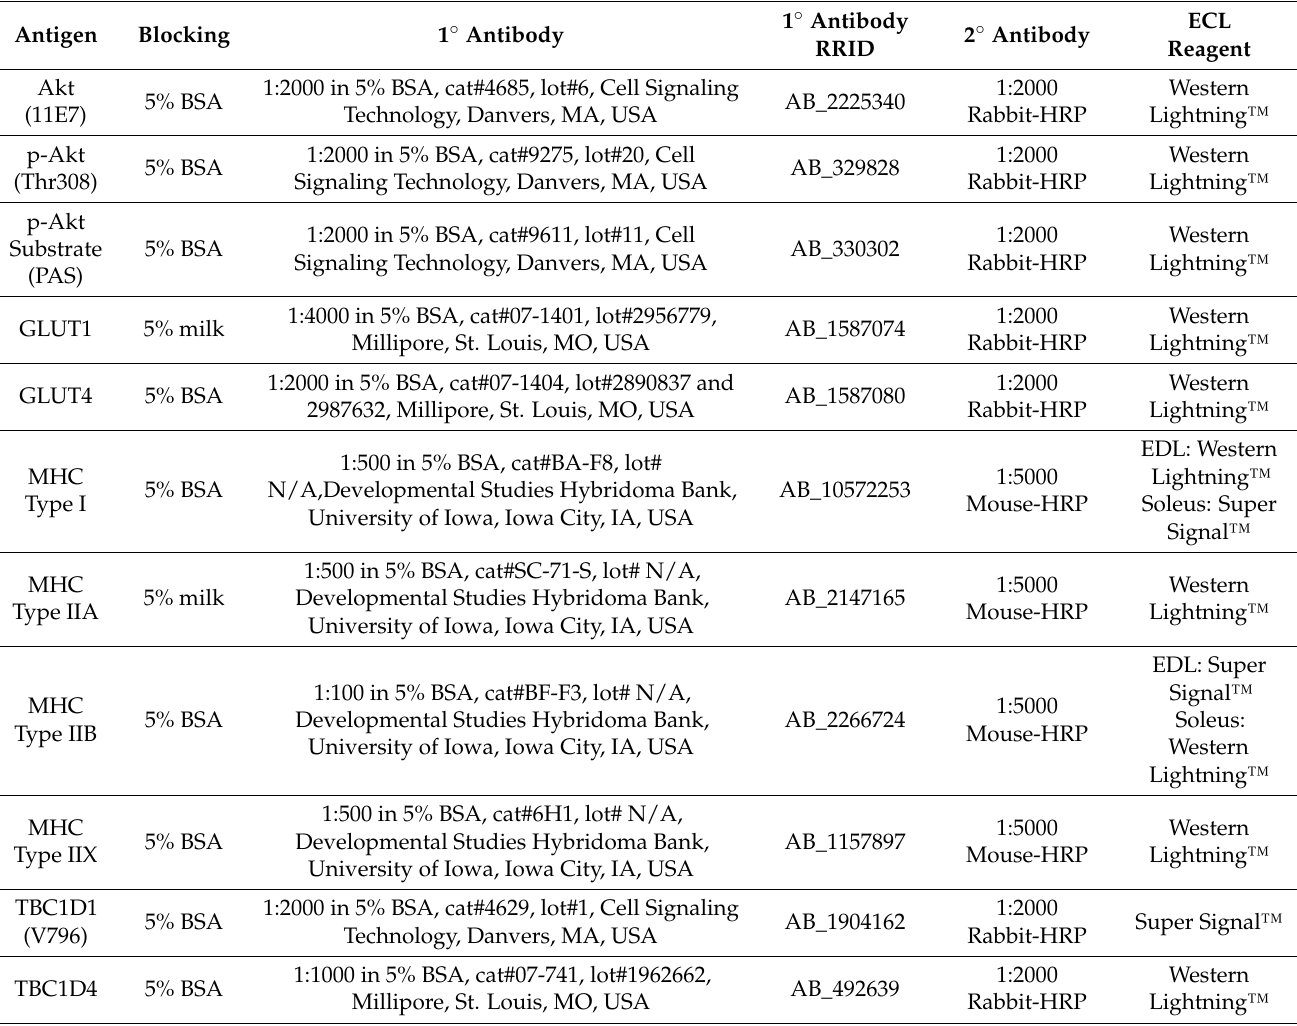
Table 1. Immunoblotting conditions.